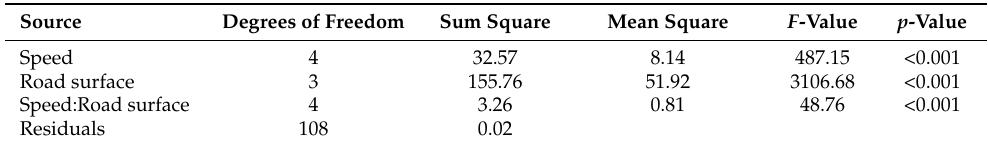
Table 3. Summarized results of two-way ANOVA, comparing mean Displacement Index D x depend- ing on speed and road surface.